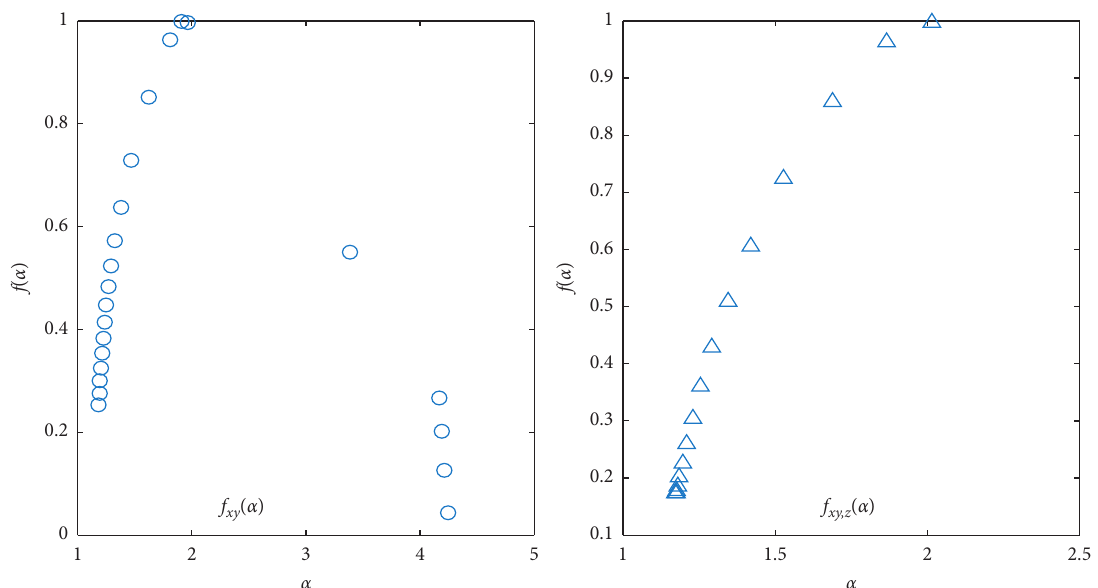
Figure 10: The multifractal spectrum f obtained through MFDPXA, where x , y , and z denote N 1, N 2, and